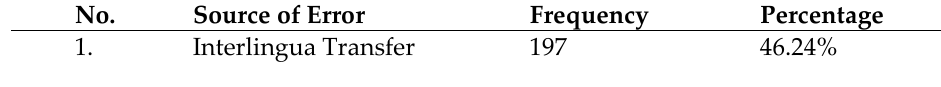
Table 4.4. The Recapitulation of Source of Error, Frequency, and its